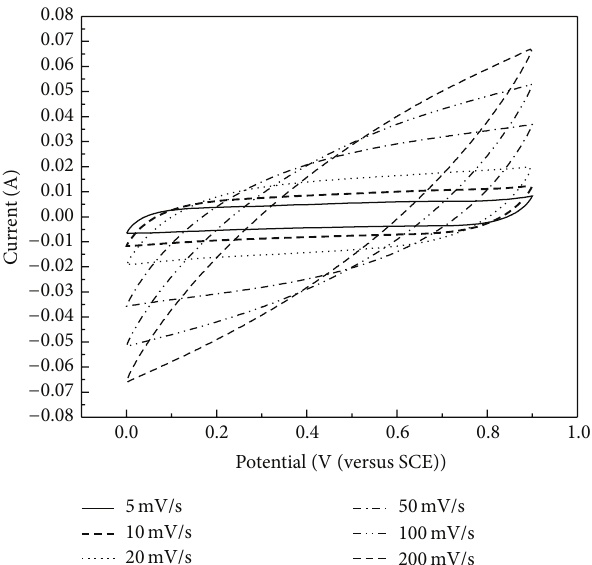
Figure 6: CVs of the sample of MMO-4 at different scan rates.